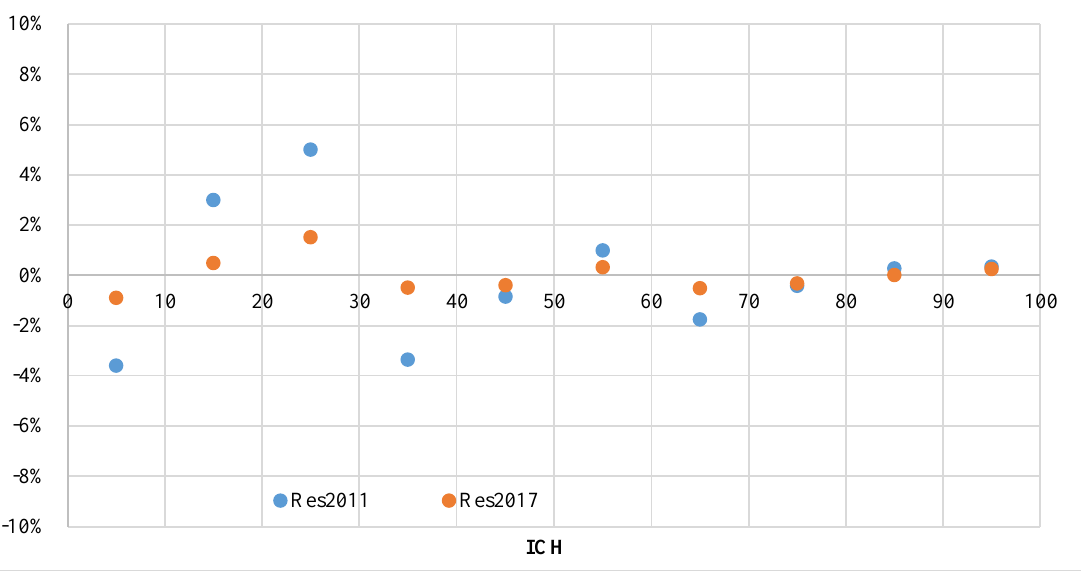
Figure 8. Residuals distributions for models with